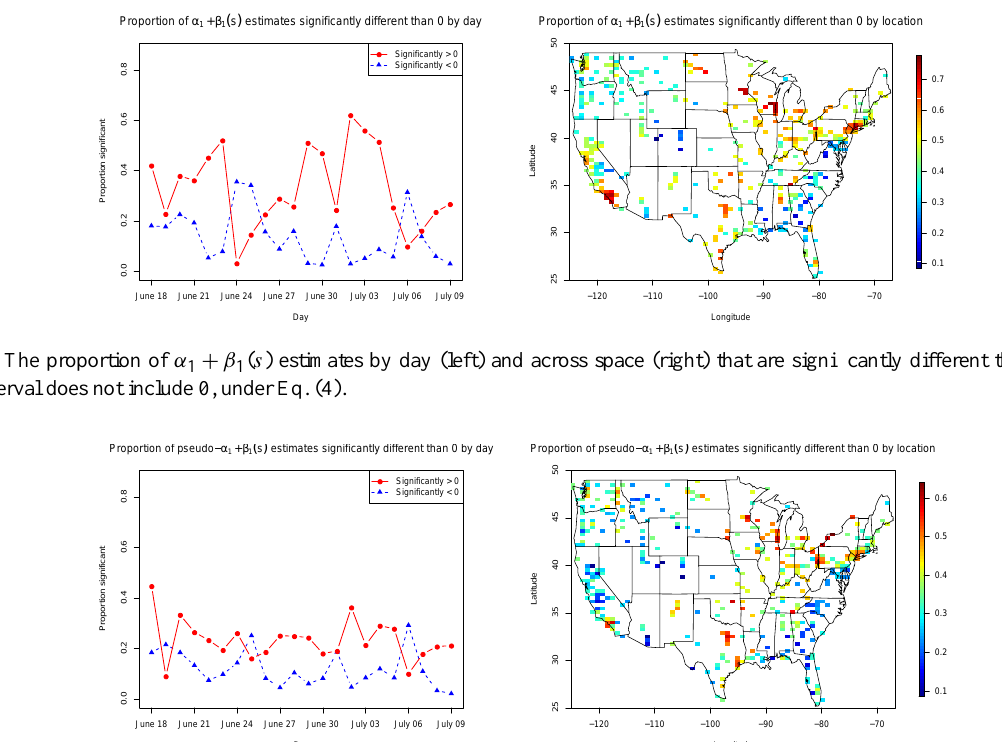
+ 1 α + β β where D − 1 is an adjusted estimate of 1 ,t 0 ,t 1 ,t A 1 α 1 ,t + β . We computed the posterior mean and 90 % cred- 1 ,t ible interval for this adjusted parameter. The significance of these estimates over time and space are shown in Fig.